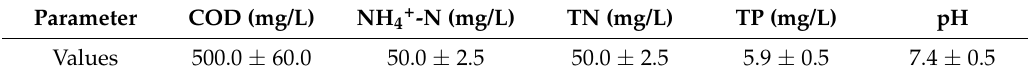
Table 1. Characteristics of the synthesis wastewater during start-up operation.